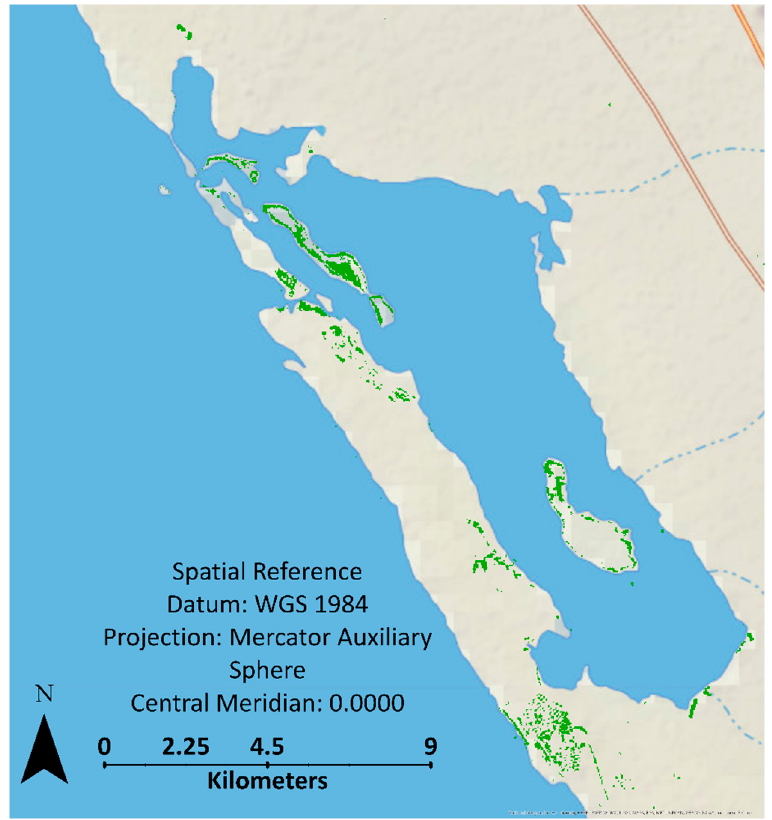
Figure 8. Median index values for disturbed and post disturbance recovery of mangroves for all twelve sites (Disturbance: 1987–2012, Recovery: 2013–2019).